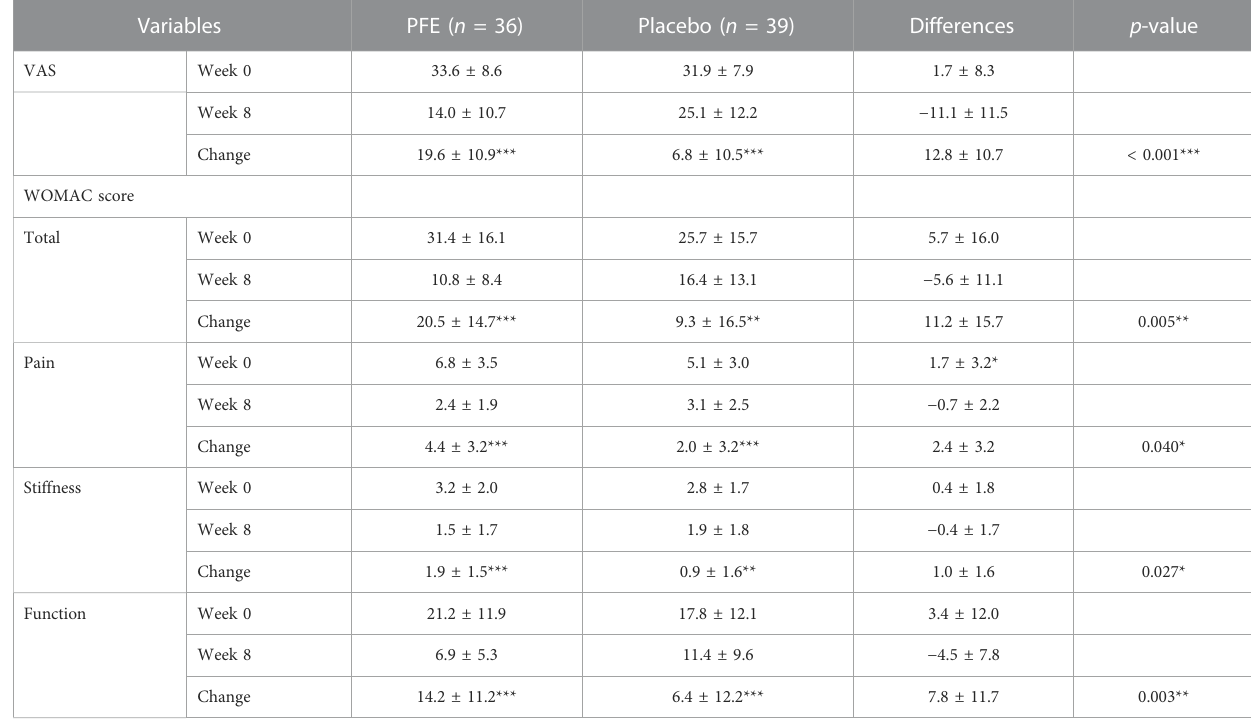
TABLE 2 Changes in primary outcomes scores after 8-week